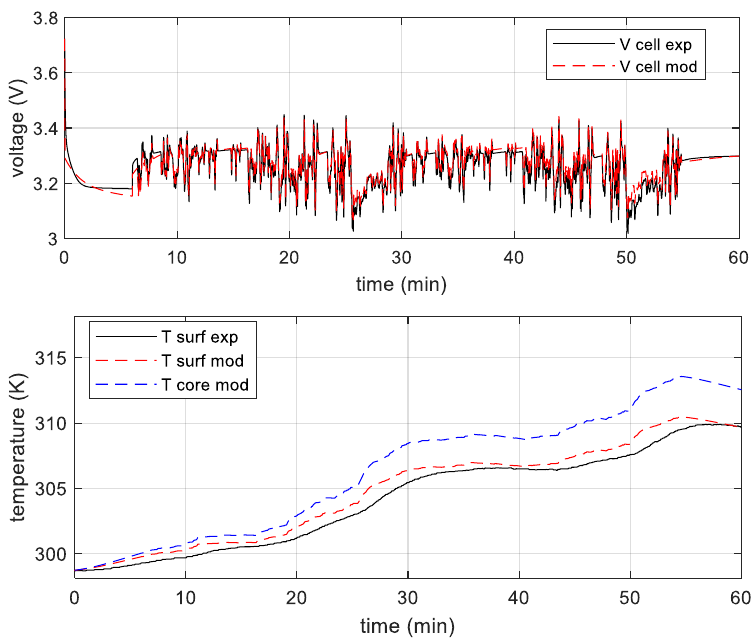
Figure 9. Experimental data and model simulation for voltage and temperature profiles, test number